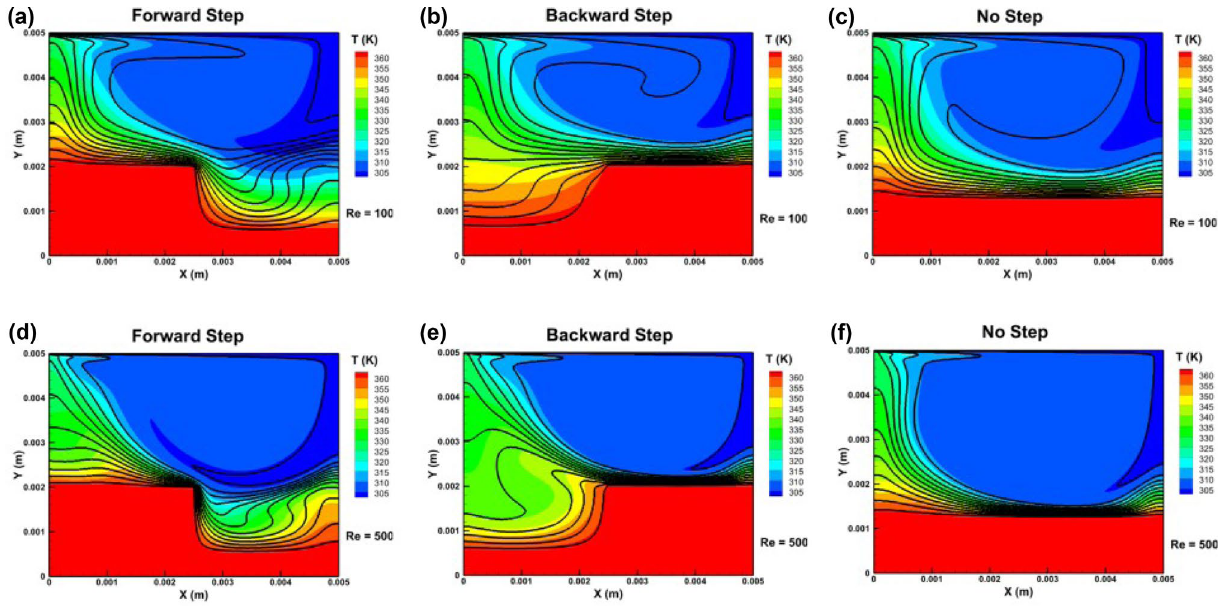
Fig. 5 Overlapped temperature contours of forced and mixed convection in all three geometrical configurations for pure water (colored contour for forced and solid black line for mixed) at Gr = 20,000: a to c at Re = 100, d to f at Re = 500